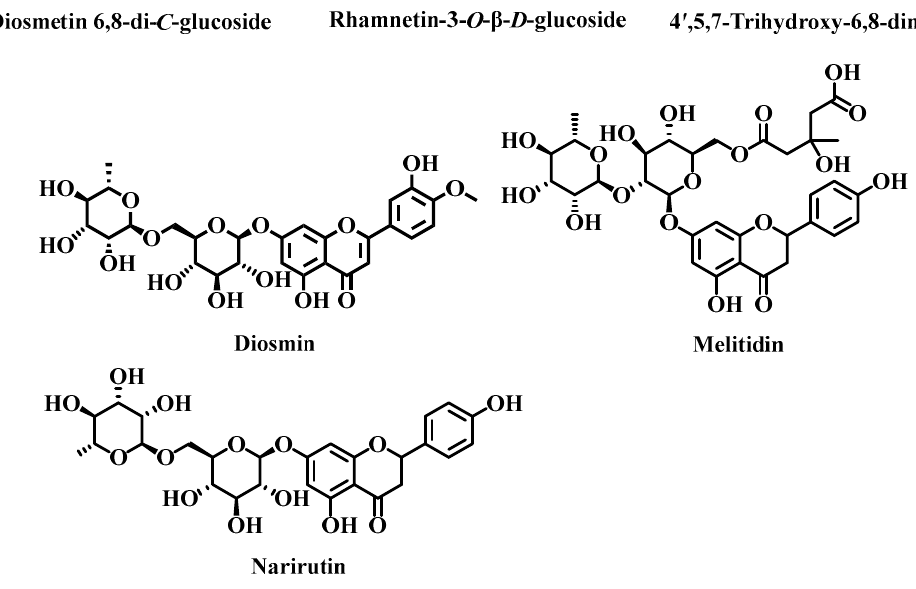
Figure 6. Chemical structures of 9 special differential metabolites.